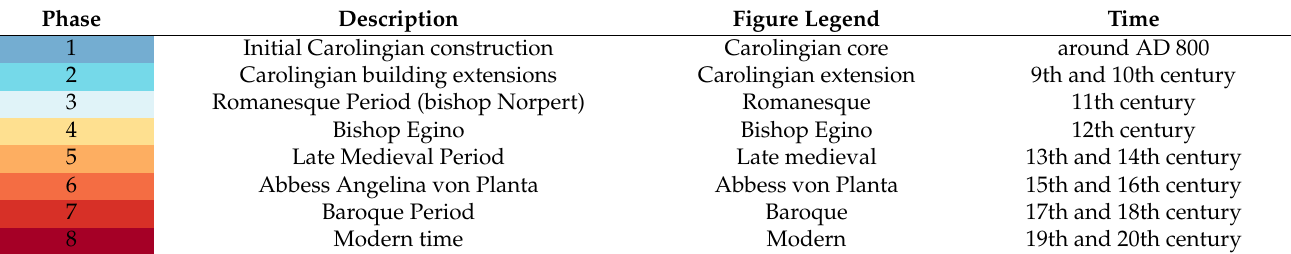
Table 1. Construction periods of the Convent of Saint John (based on [31]).